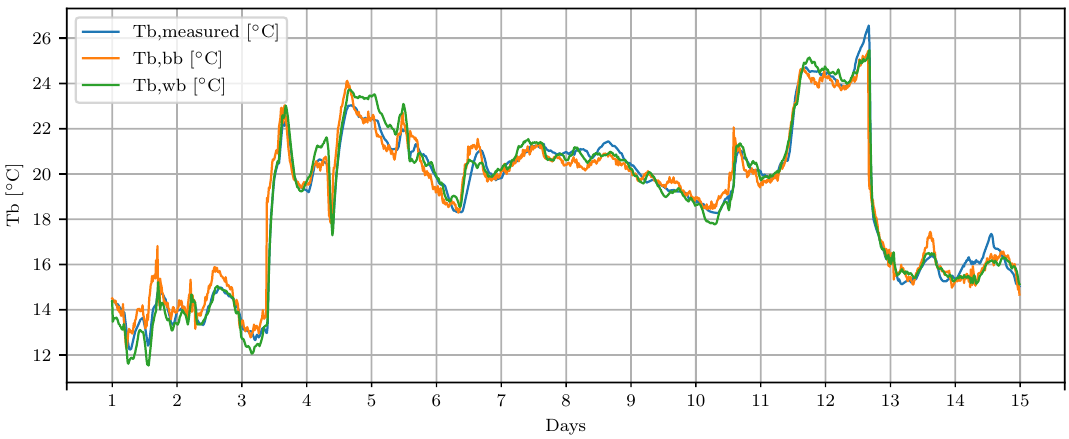
Figure 10. Time series plot of the measured and simulated basin temperature, for the white box model (T b,wb ) and the black box model (T b,bb